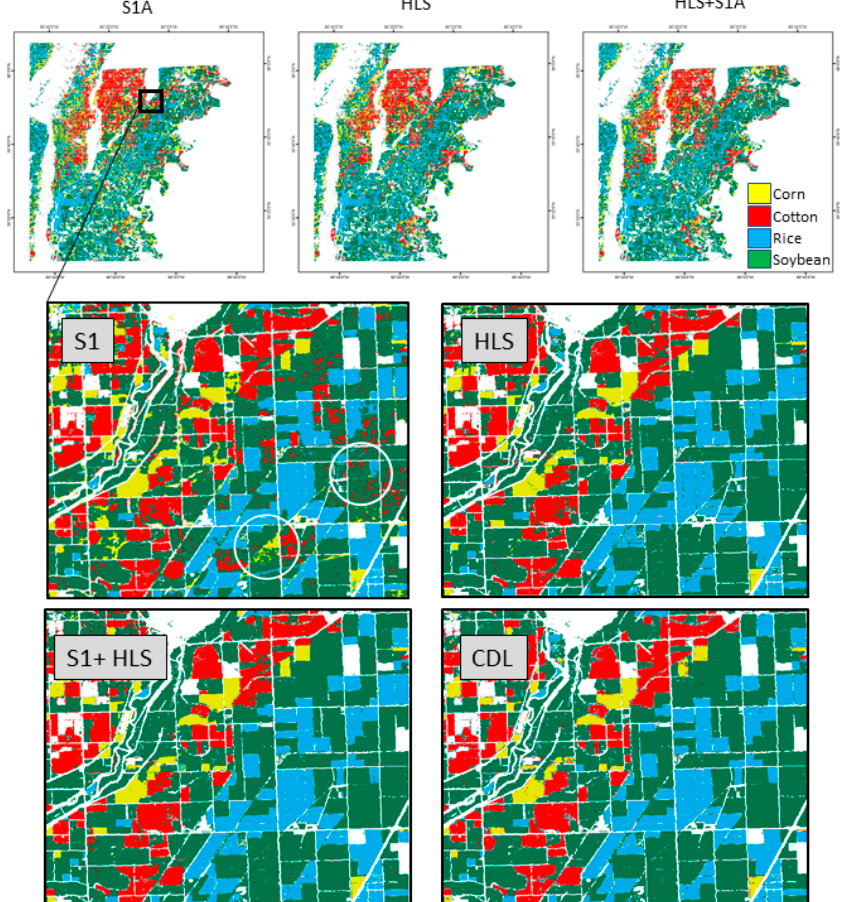
Figure 5. Example end of season crop type classification maps in northeast Arkansas by sensors showing a generally strong ability to map major crop type within season at the field scale. The highlighted are example S1 that are only misclassification among corn, soy, and cotton.